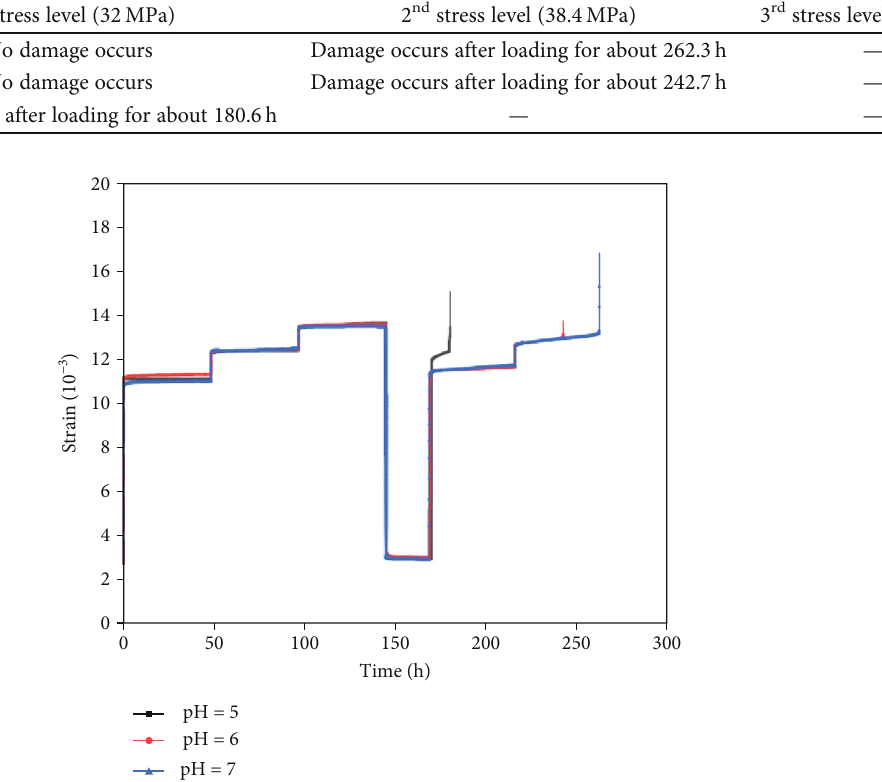
Figure 10: Comparison of uniaxial compression creep curves of gypsum under di ff erent